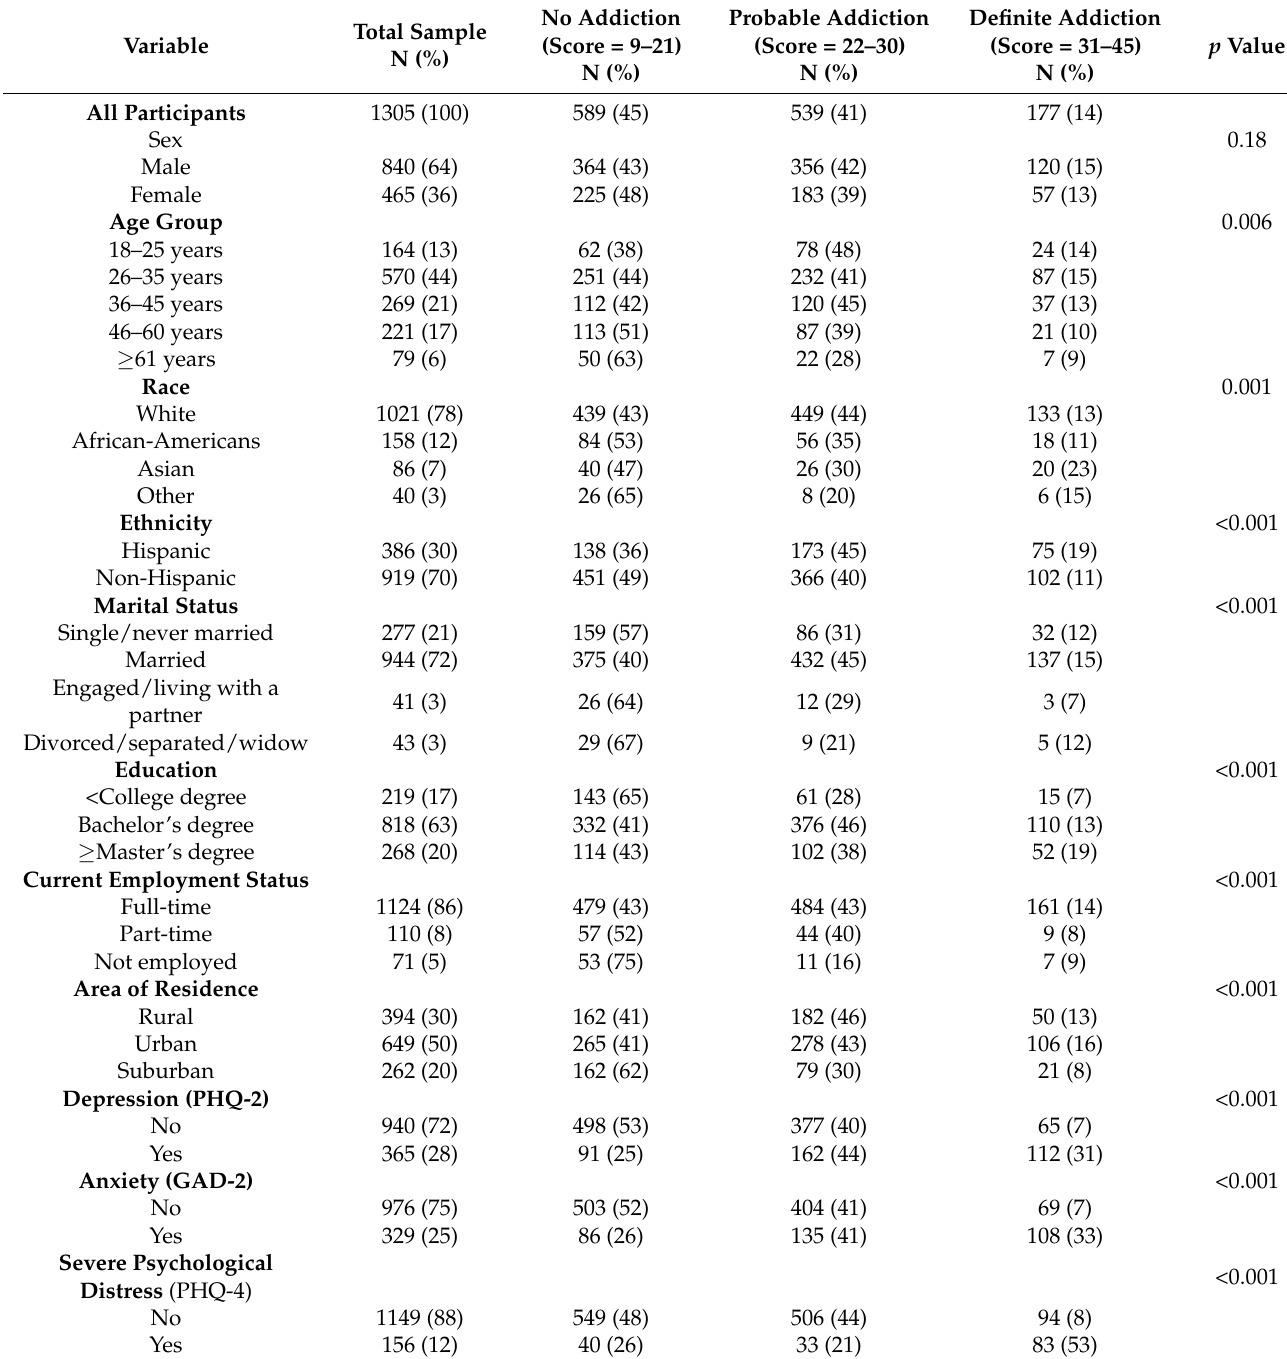
Table 2. Demographic Characteristics, Internet Addiction, and Psychological